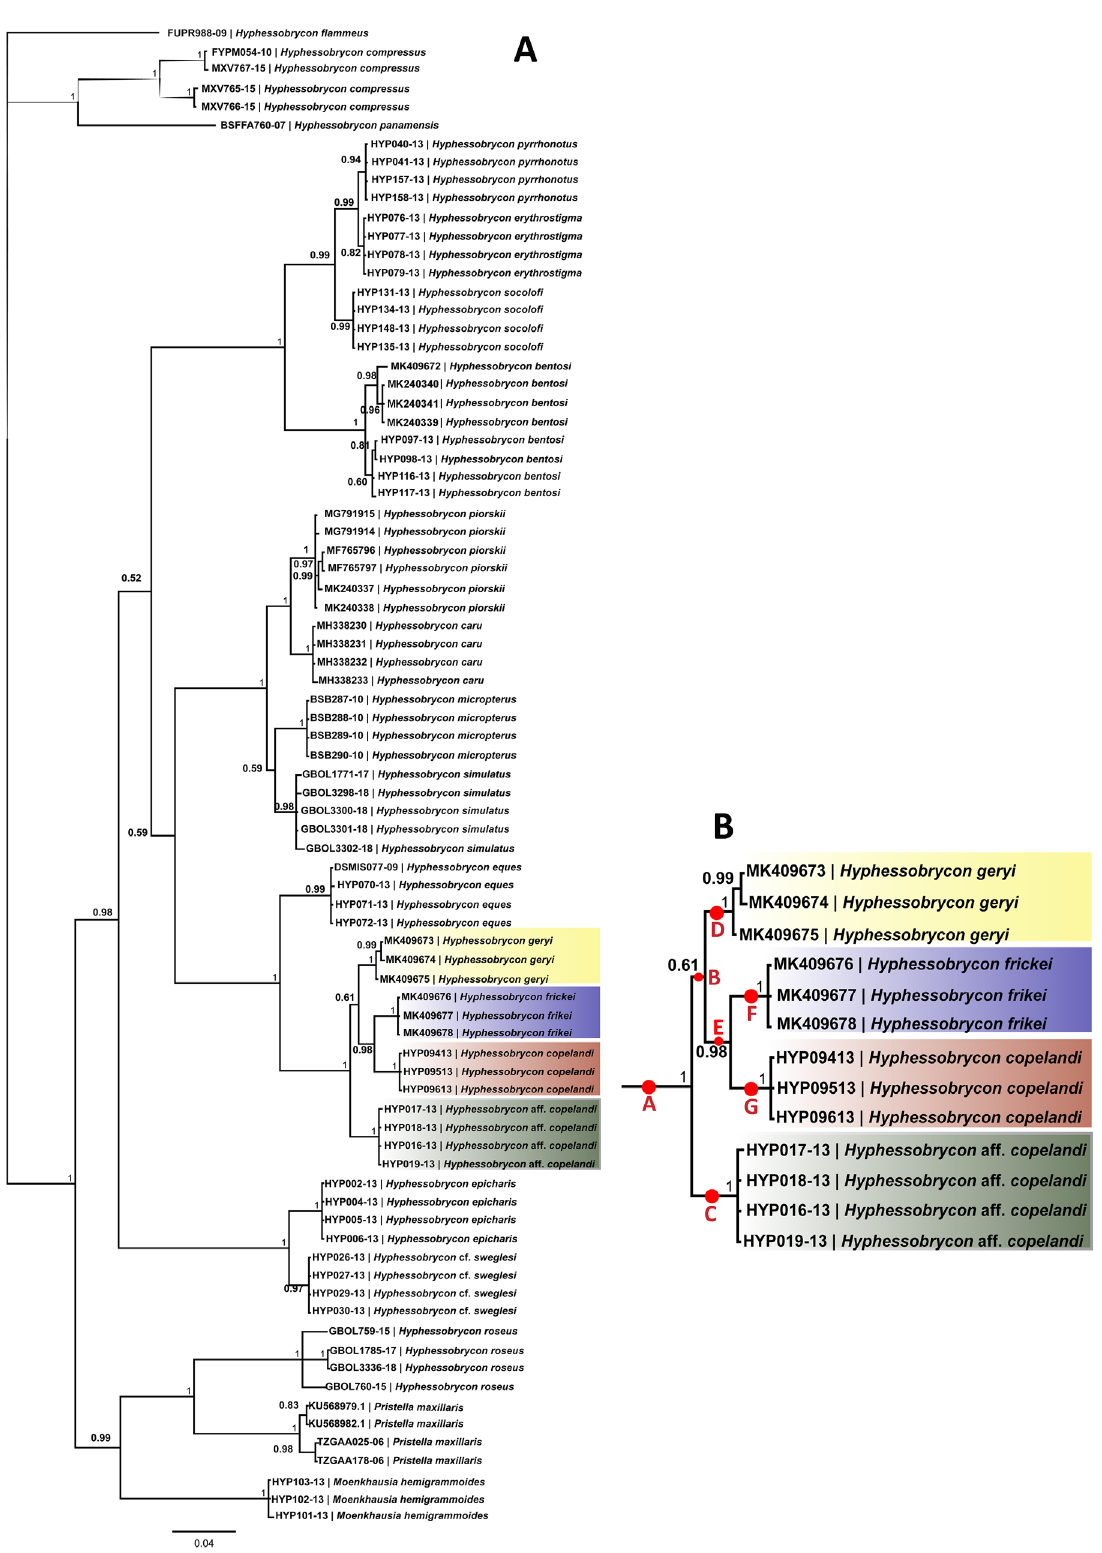
Fig. 7. A . Bayesian Inference phylogenetic tree (BI). B . Detached relationships between members of the of the Hyphessobrycon copelandi clade. Numbers above and below branches are posterior probability values, and red letters correspond to synapomorphic nucleotide substitutions listed in Appendix